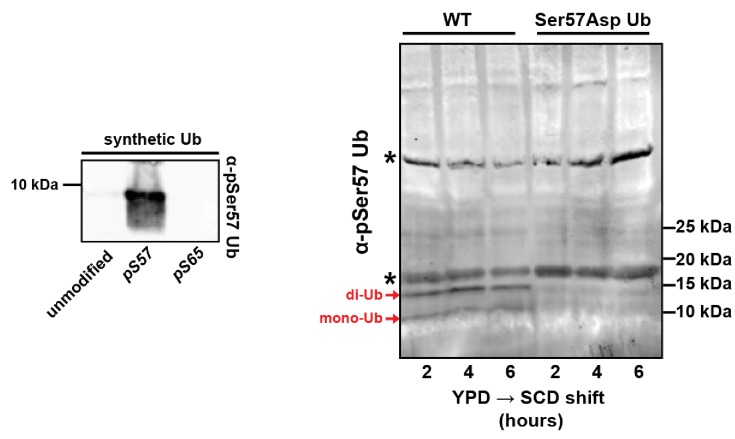
Analysis of antibodies recognizing pSer57 ubiquitin.The left panel shows immunoblot analysis of synthetic ubiquitin, phospho-Ser57 ubiquitin, and phospho-Ser65 ubiquitin using an α-phospho-Ser57-specific antibody. The right panel shows immunblot analysis using the same antibody to probe lysates from yeast expressing only wild-type ubiquitin or Ser57Asp ubiquitin. Many background bands are apparent but two low MW bands corresponding to mono- and di-ubiquitin are recognized by the antibody in a Ser57-specific manner.